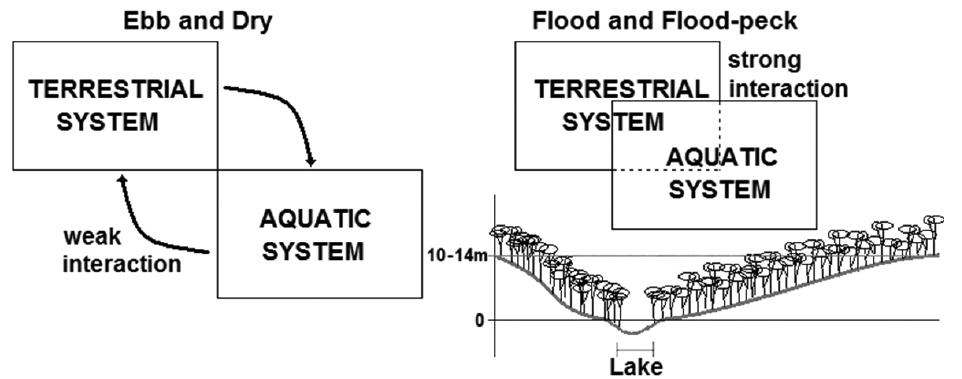
Figure 8. Degree of interaction and connectivity between terrestrial ecosystems and Catalão Lake as a function of the hydrological